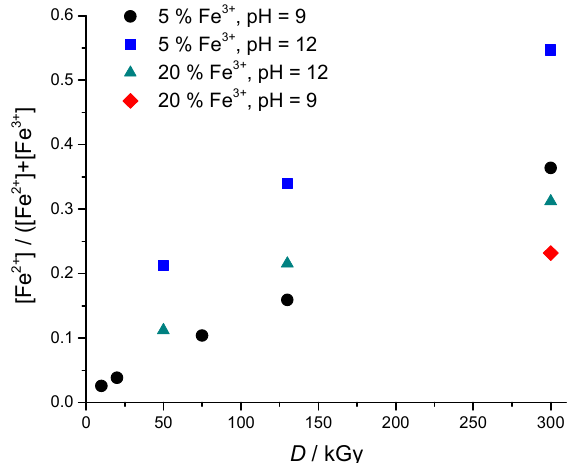
Figure 8. The Fe 2 + fraction ([Fe 2 + / (Fe 2 + + Fe 3 + )]) in relation to dose, pH and initial amount of Fe 3 +